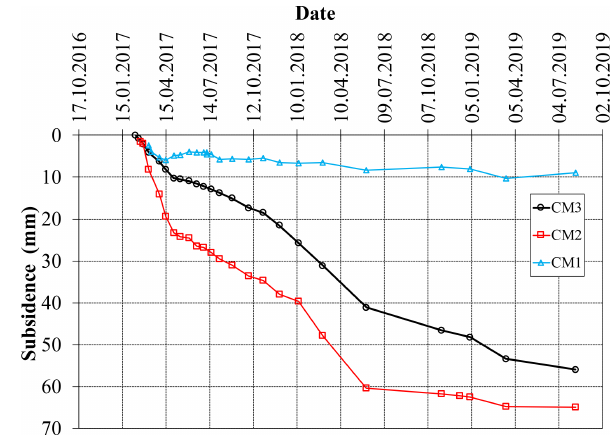
Figure 6. Measured ground surface subsidence relative to bench- marks at 100m depth.